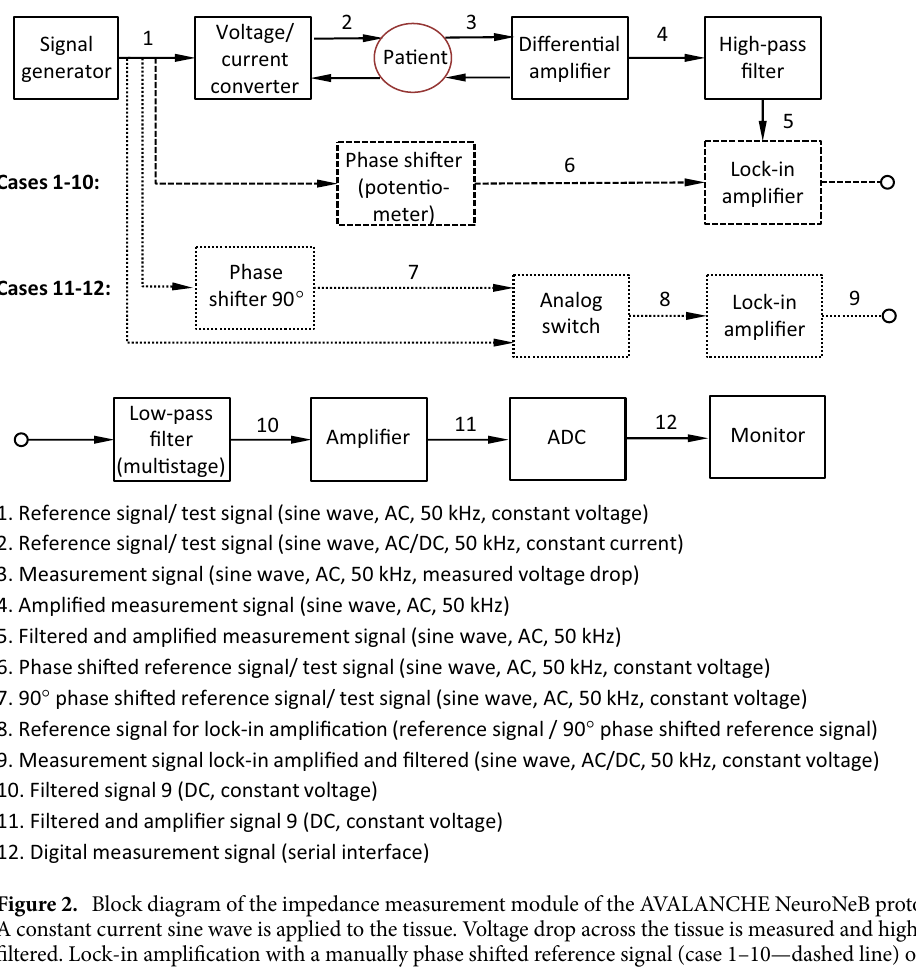
Figure 2. Block diagram of the impedance measurement module of the AVALANCHE NeuroNeB prototype. A constant current sine wave is applied to the tissue. Voltage drop across the tissue is measured and high pass filtered. Lock-in amplification with a manually phase shifted reference signal (case 1–10—dashed line) or alternated with a sine and a cosine reference signal (case 11 and 12—dotted line) followed. The low pass filtered and amplified signal is fed into an analog-digital-converter and displayed on the neuromonitor, representing tissue